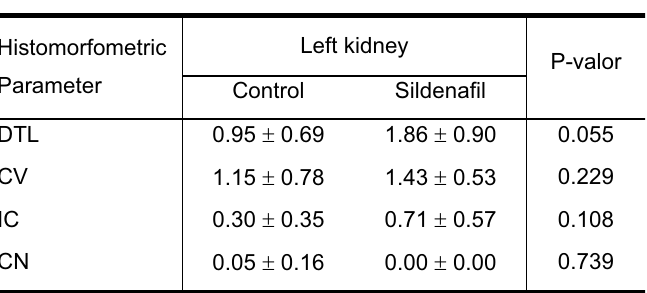
TABLE 4 - Scores Data on the histopathologic changes in the left kidney, comparing the control and sildenafil groups, after seven days